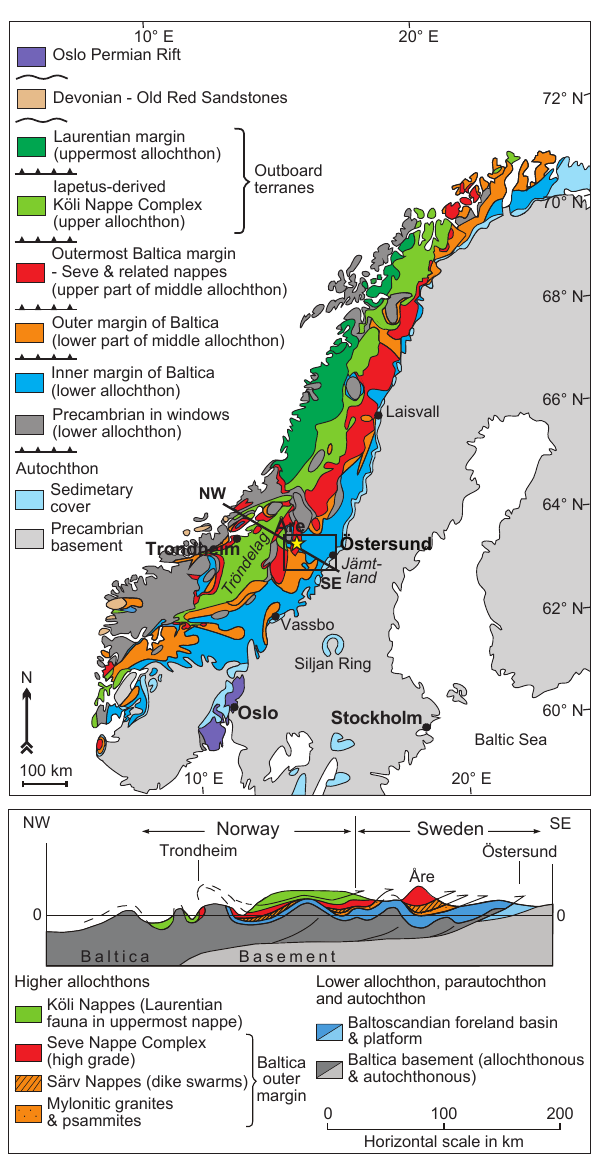
Figure 1. (a) Provenance interpretation of the tectonostratigraphic map of the Scandinavian Caledonides, modified from Gee et al. (1985). The star marks the location of the COSC-1 borehole. (b) Schematic cross section (vertical exaggeration x10) along the NW–SE profile in (a), from Gee et al. (2010). The autochthonous basement (light gray) is separated from the Caledonian deformed basement (dark gray) by the Scandian sole